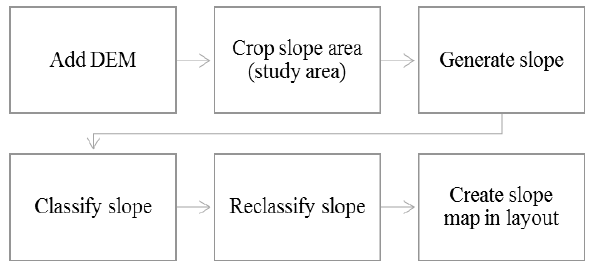
Figure 12. Flow of Slope Map Generation and Classification in ArcGIS Software